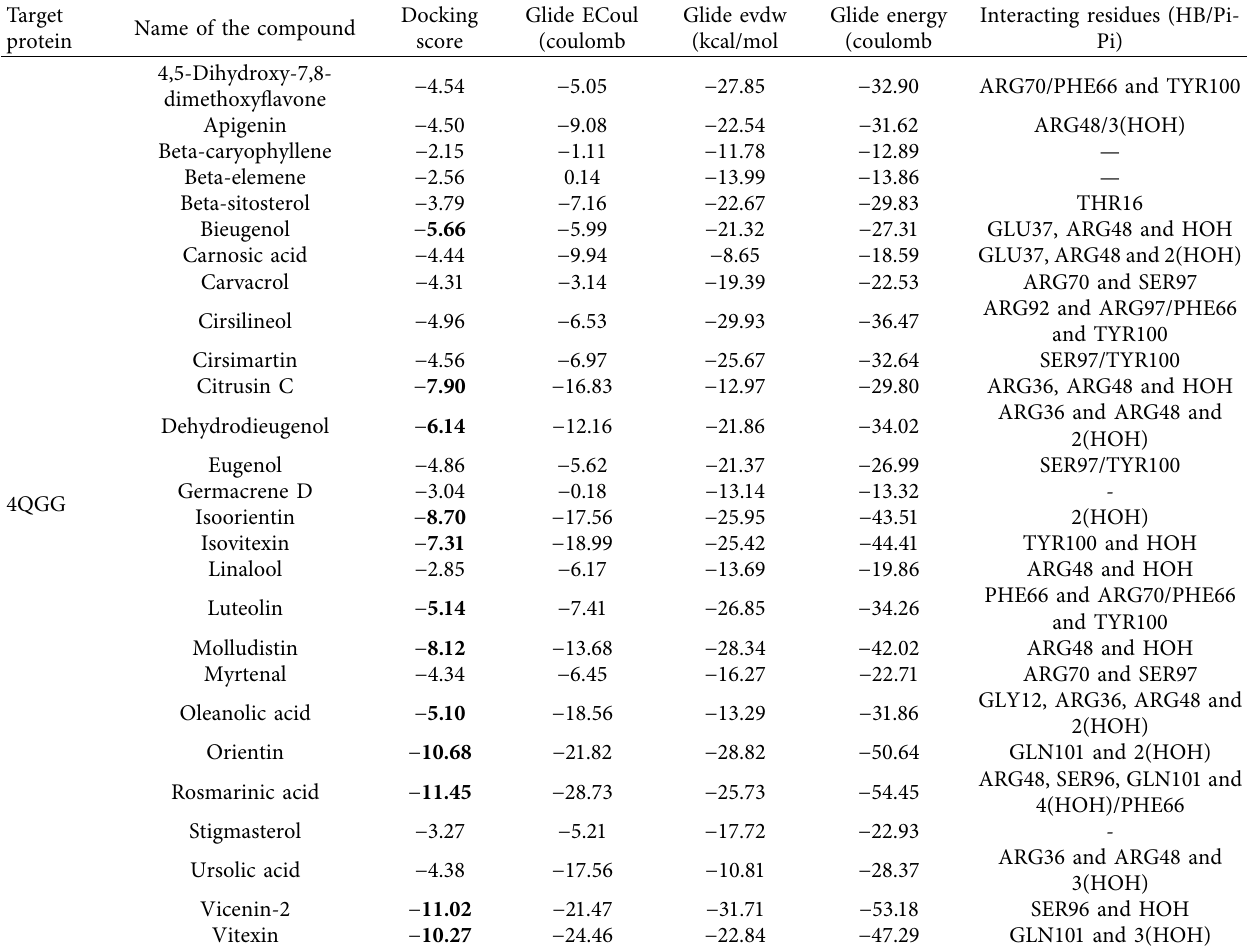
Table 2: The docking score, ECoul (Coulomb energy), Glide evdw (van der Waals energy), interacting residues, and the type of interaction of 27 bioactive substances with the protein thymidylate kinase were calculated (TMPK). The docking scores were determined using Schrodinger Maestro Glide software (version 2018.1), where HB stands for hydrogen bonding and Pi-Pi stands for a